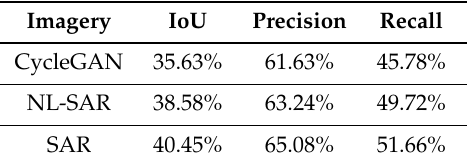
Table 3. Test results of DeepLabv3+ trained for road segmentation on various image